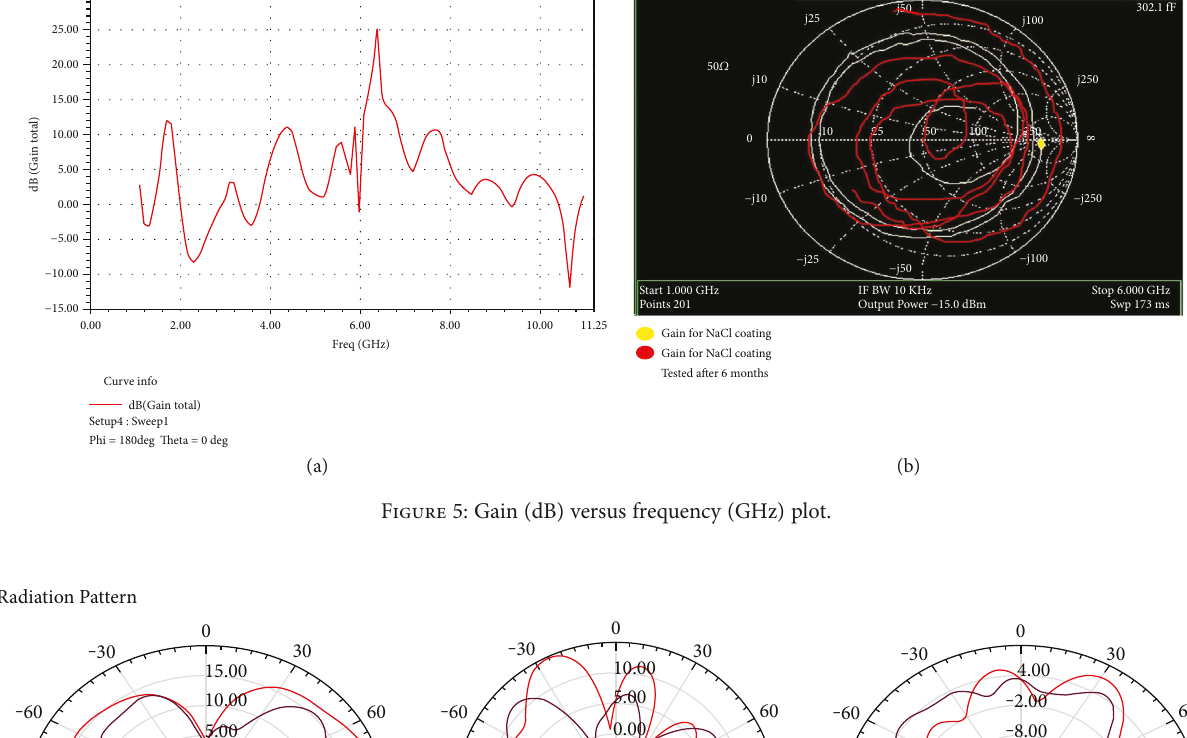
Figure 5: Gain (dB) versus frequency (GHz) plot.